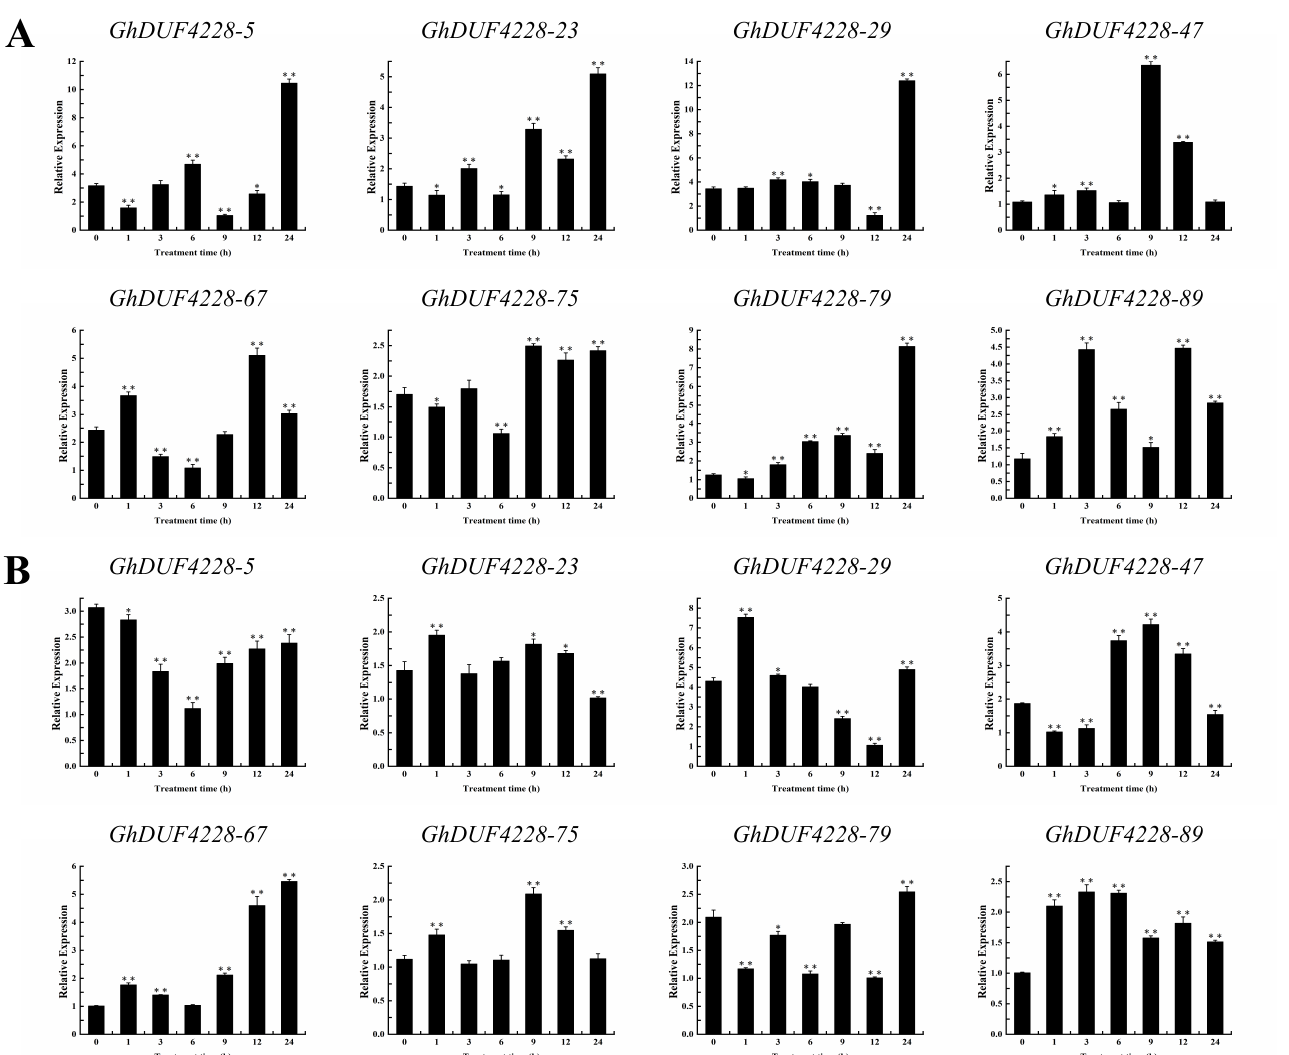
Figure 7. Expression patterns of GhDUF4228 genes under ABA and MeJA treatments. ( A ) Expression levels of GhDUF4228 genes at 0, 1, 3, 6, 9, 12, and 24 h under ABA treatment. ( B ) Expression levels of GhDUF4228 genes at 0, 1, 3, 6, 9, 12, and 24 h under MeJA treatment. Error bars represent